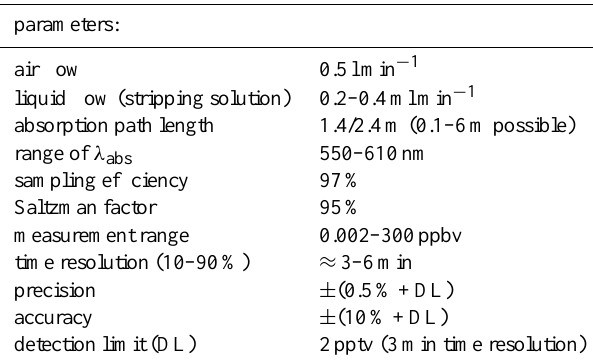
Fig. 5. NO 2 uptake coefficients as a function of [NEDA] 1 / 2 at Fig. 5 NO 2 uptake coefficients as a function of [NEDA] 1/2 at 288 K. Griess-Saltzman 288K. Griess-Saltzman Reagent: 7gl − 1 sulphanilamide, 84gl − 1 Reagent:7 g/l sulphanilamide, 84 g/l acetic acid, pH = 3, adjusted with NH 3 . Air acetic acid, pH=3, adjusted with NH 3 . Air flow=650mlmin − 1 , liquid flow=0.35mlmin − 1 flow = 650 ml/min, liquid flow = 0.35 ml/min.